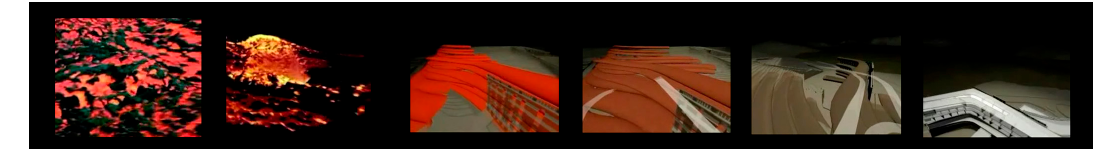
Figure 1. Zaha Hadid, Casino and Grand Hotel in Lugano. Movie by Neutral (0:58), 1999.